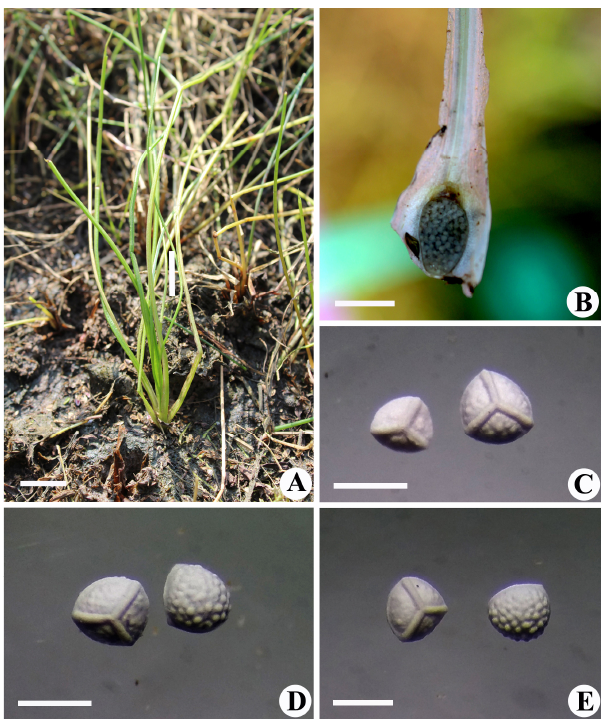
Fig. 1. Isoetes coromandeliana